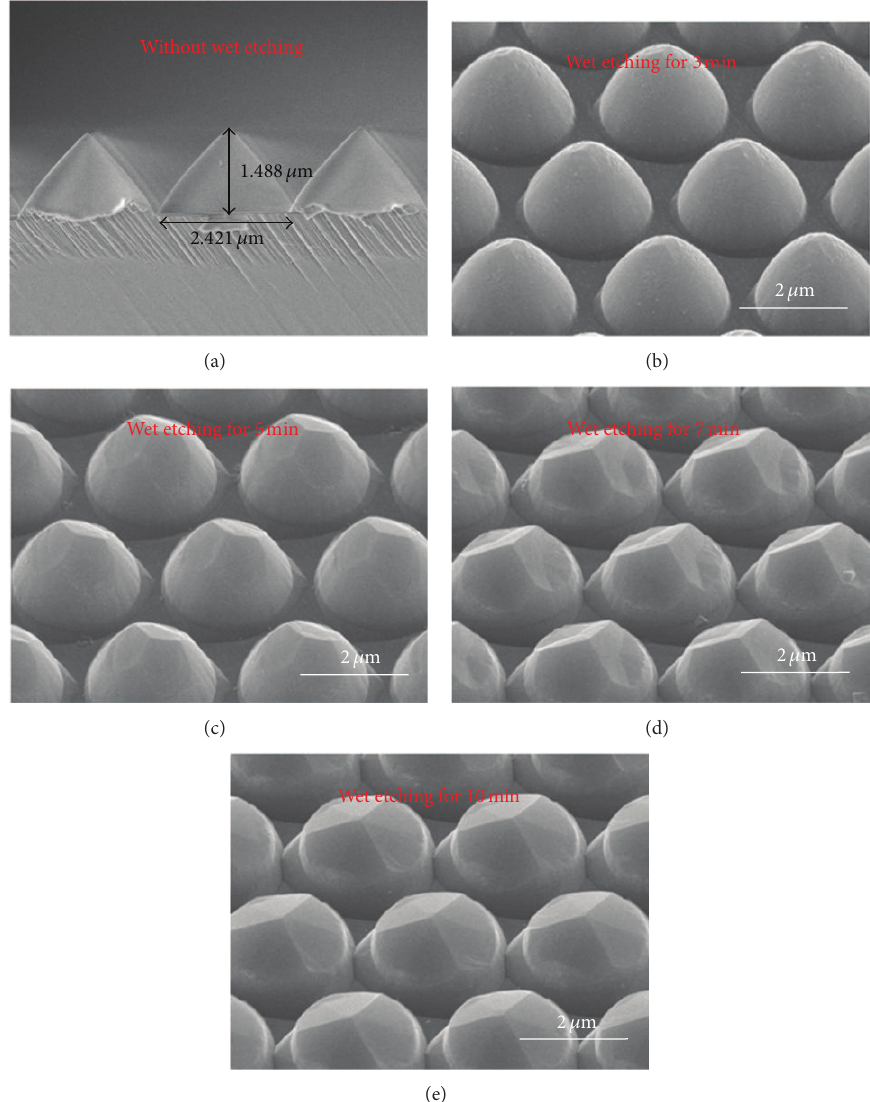
Figure 1: (a) Cross-sectional SEM image of cone-shaped PSS without treatment by wet etching and plane-view SEM images of cone-shaped PSSs subjected to wet etching for (b) 3 min, (c) 5min, (d) 7 min, and (e)